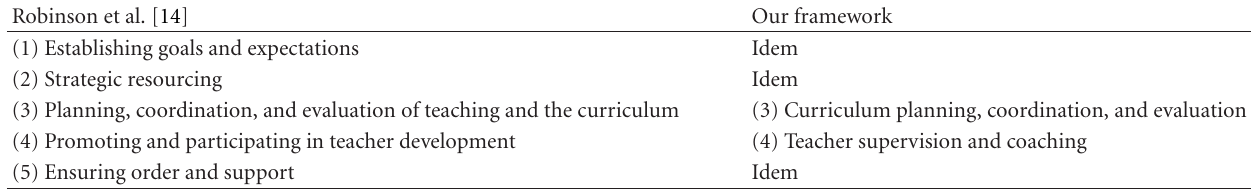
Table 1: Dimensions of Robinson et al. [14] with